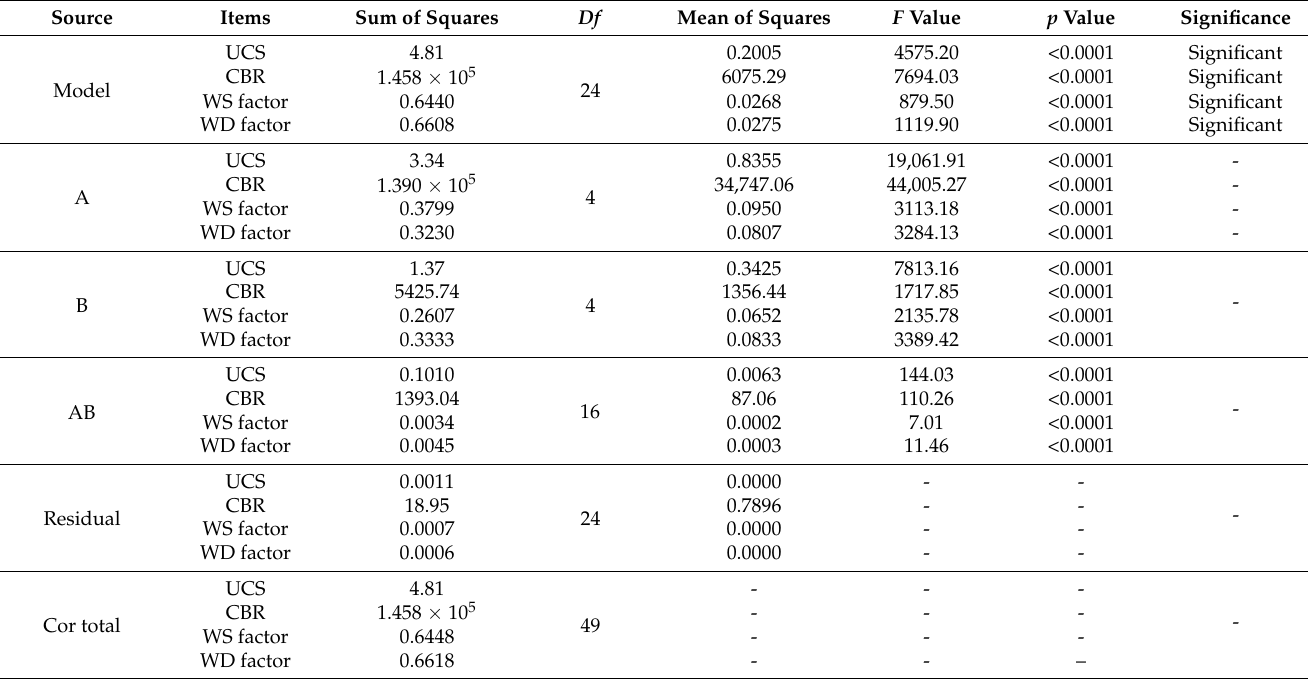
Table 3. The results of variance